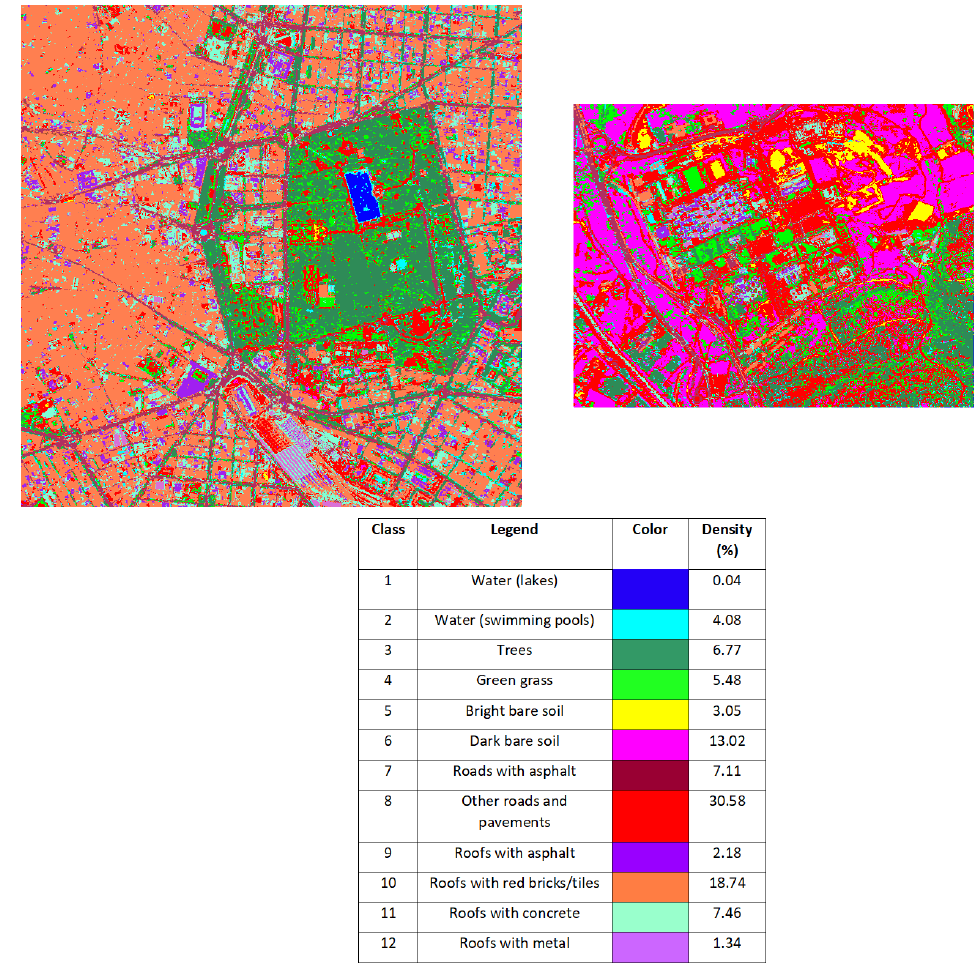
Figure 3. The 4-m classification map derived from AHS and in-situ data, over the Retiro Park ( top left ), over the UAM ( top right ), with the legend and the density of each class in percentage ( bottom